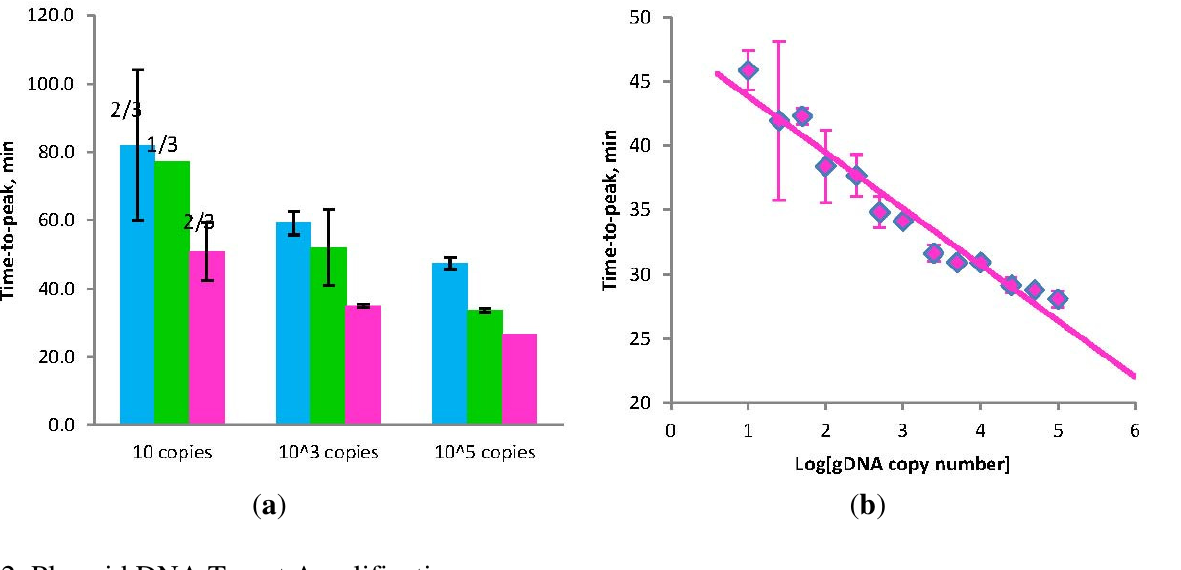
Figure 2. ( a ) Amplification times for LAMP without Loop primers (blue) and STEM-LAMP with Stem primers instead of Loop primers (pink) for 10, 1000 and 100,000 copies of genomic Clostridium difficile DNA target; STEM-LAMP without displacement primers for the same number of copies is shown in green; ( b ) a six log dilution series of Clostridium difficile toxin B gene using STEM-LAMP (all dilutions were measured and detected in triplicate unless indicated otherwise). Final primers concentrations were: Cd-BIP, Cd-FIP, Cd-StemB and Cd-StemF ― 1.6 µM each, Cd-DisplB and Cd-DisplF ― 0.4 µM each. Each set of data included three no template controls (NTCs), that remained clean throughout the duration of the assay and were not associated with any time-to-peak value (hence not shown graphically). Error bars represent standard deviations of triplicate